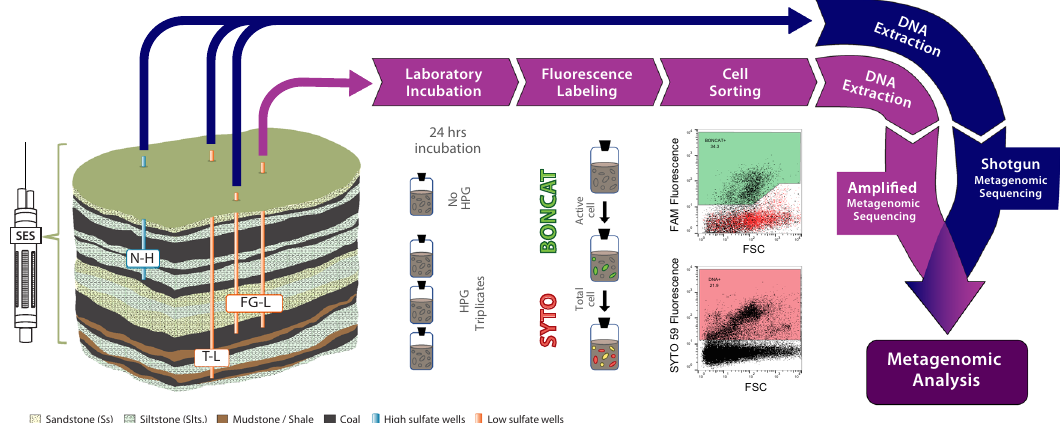
Fig. 1 Schematic depicting experimental work fl ow. High-sulfate (Nance, N-L) and low-sulfate (Flowers Goodale, FG-L; Terret, T-L) CBM wells were sampled utilizing a Subsurface Environmental Sampler (SES) to retrieve in situ CBM samples of the attached fraction under environmentally relevant conditions. Following retrieval, samples were either prepared for BONCAT incubation (purple track) or shotgun metagenomics (blue track). For shotgun metagenomics, DNA was extracted and sequenced. BONCAT incubations with the synthetic amino acid tracer, HPG, lasted 24 h followed by cell removal from coal, click chemistry, staining, and cell sorting of BONCAT + and BONCAT-Total (SYTO stained) cell fractions, DNA extraction and ampli fi ed metagenomic sequencing. The No HPG control was used to determine sorting gates for BONCAT +